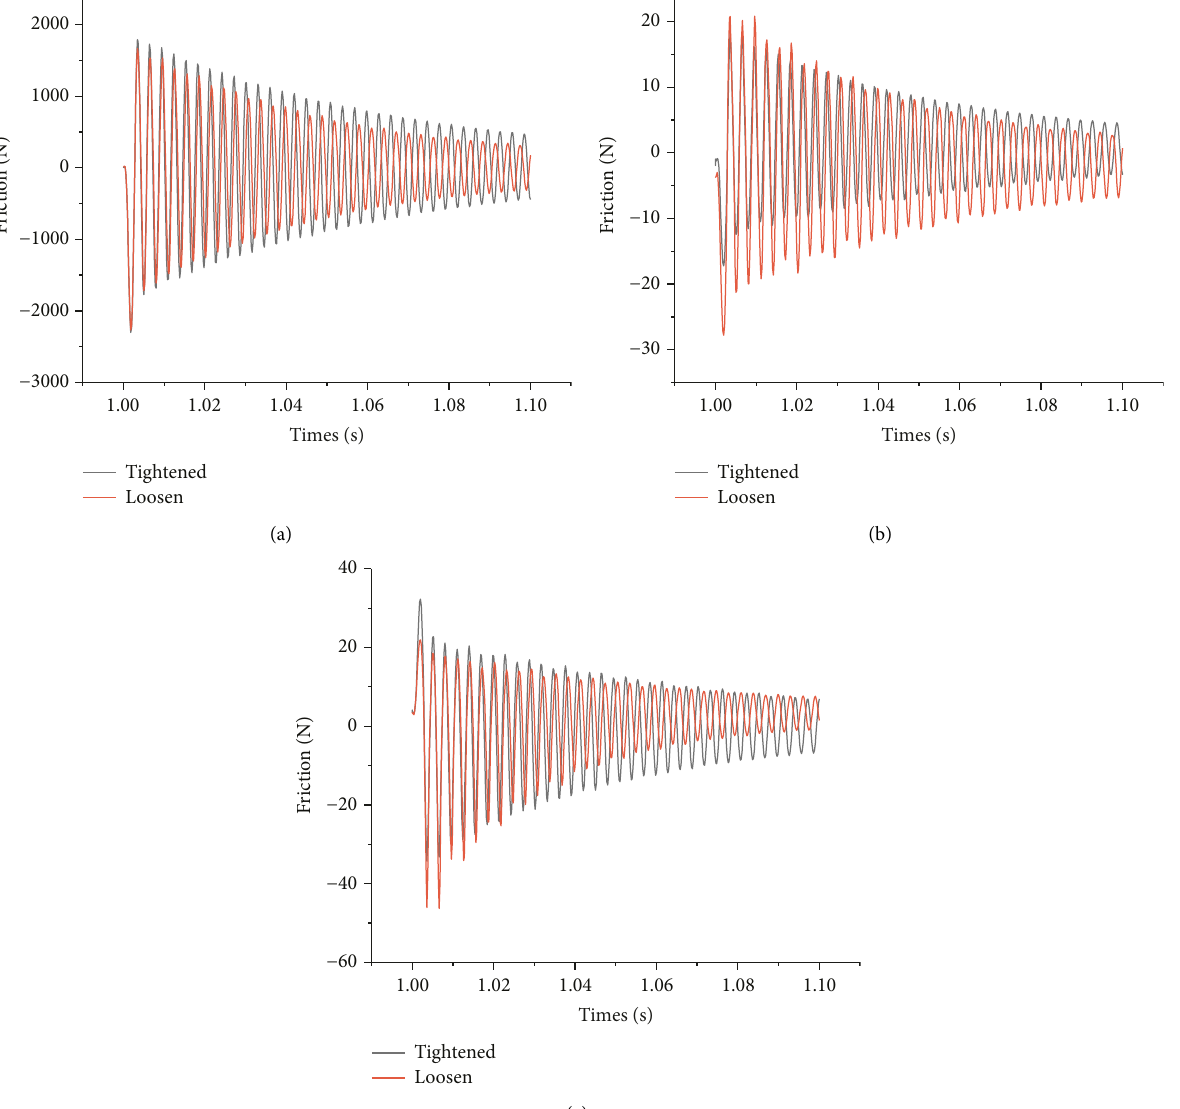
Figure 20. The total highest stress of the loose bolt arises on the side away from the center of the joint surface and at the thread during the entire vibration process.